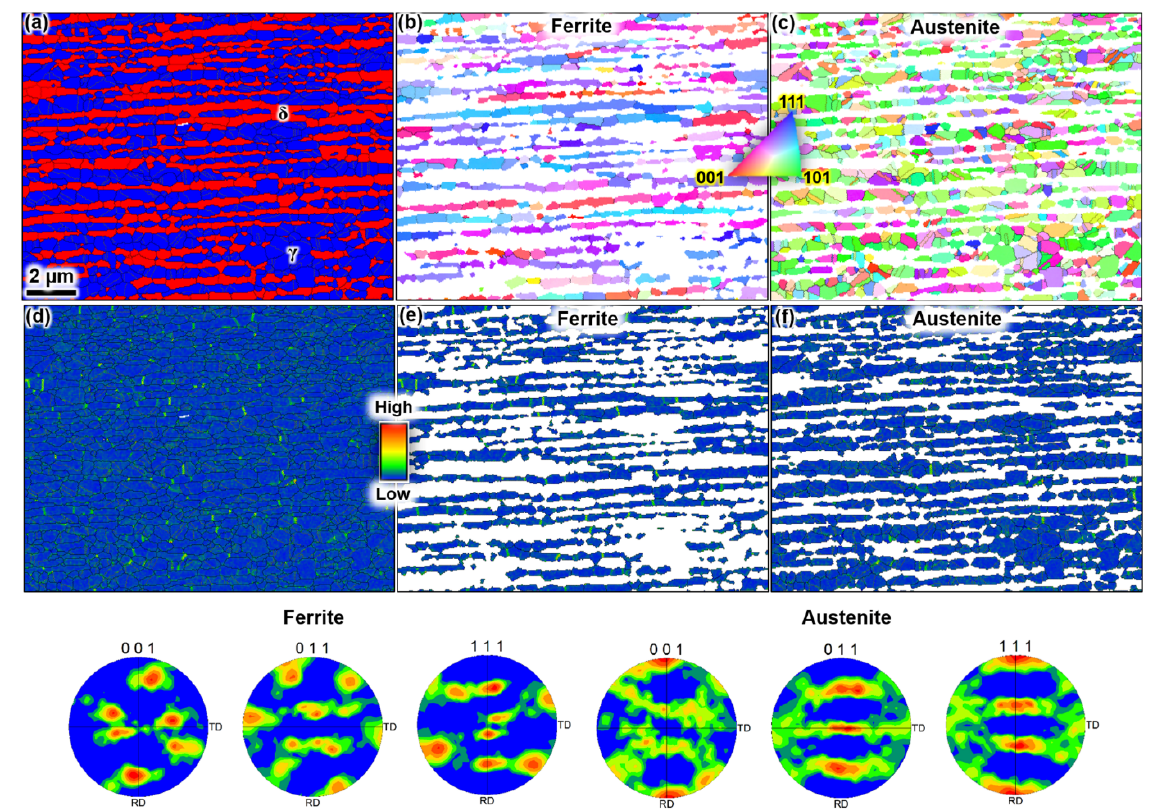
Figure 1. EBSD analysis results showing ( a ) the phase distribution of ferrite (red) and austenite (blue) grains, ( b ) the grain orientations (IPF map) for the ferrite phase, ( c ) the grain orientations (IPF map) for the austenite phase, ( d ) local misorientation distribution (Kernel average) of the entire microstructure and ( e ) for the ferrite phase and ( f ) for the austenite phase. The pole figures in the bottom show the crystallographic texture of ferrite and austenite grains, with the colour contours showing the strength of the texture.